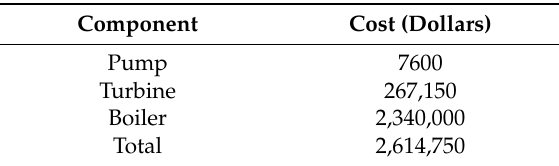
Table 11. Fixed capital investment costs [27].